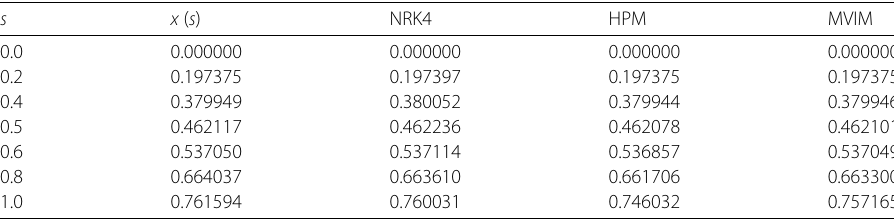
Table 1 The results of different methods for Example 1, α = 1 s x ( s ) NRK4 HPM MVIM